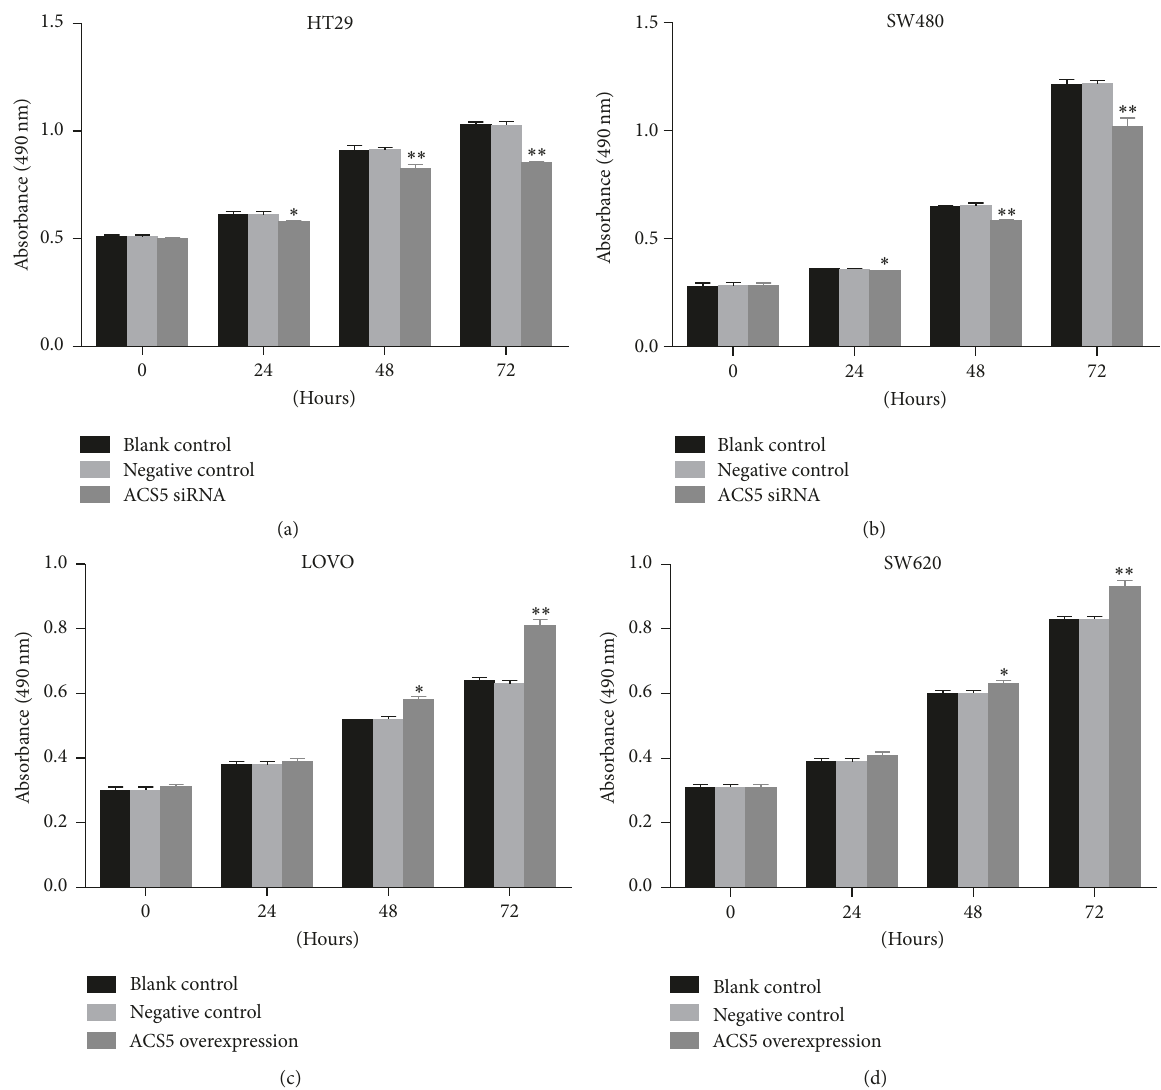
Figure 4: Effect of ACS5 on the proliferation of CRC cells. Cell proliferation was evaluated by MTS, and the results of cell growth were expressed by absorbance at 490 nm. ((a), (b)) The proliferation inhibition of HT29 and SW480 cells with ACS5 knockdown was observed compared with negative control and blank control at 24 h, 48 h, and 72 h. ((c), (d)) The proliferation promotion of LOVO and SW620 cells with ACS5 overexpression was observed compared with negative control and blank control at 48 h and 72 h. ∗∗ 𝑃 < 0.01 , ∗ 𝑃 < 0.05 versus negative control or blank control